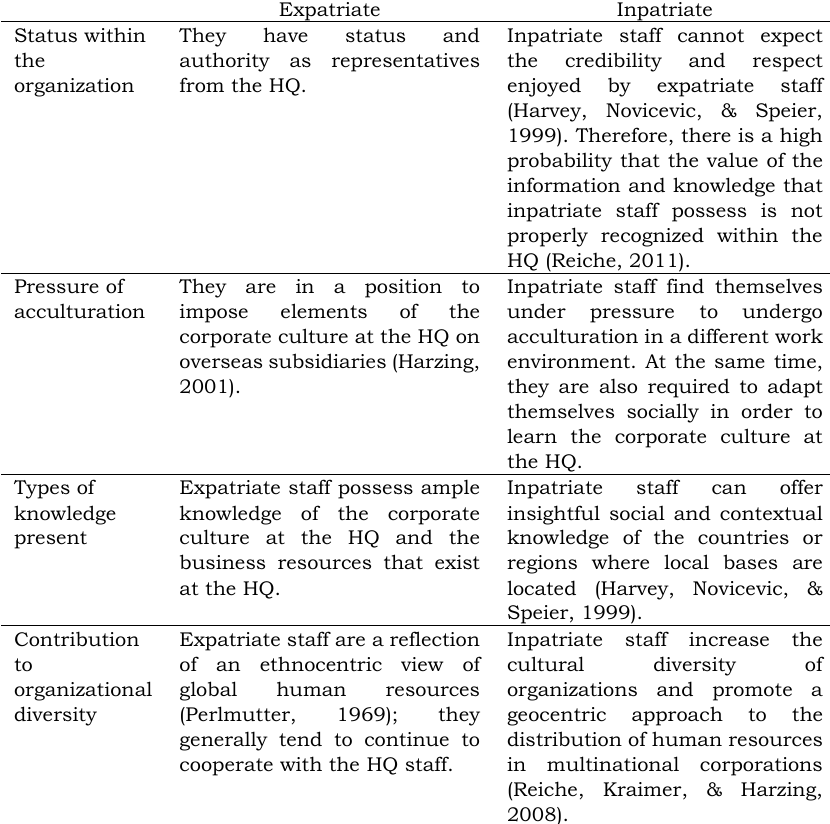
Table 1. Differences between expatriate and inpatriate